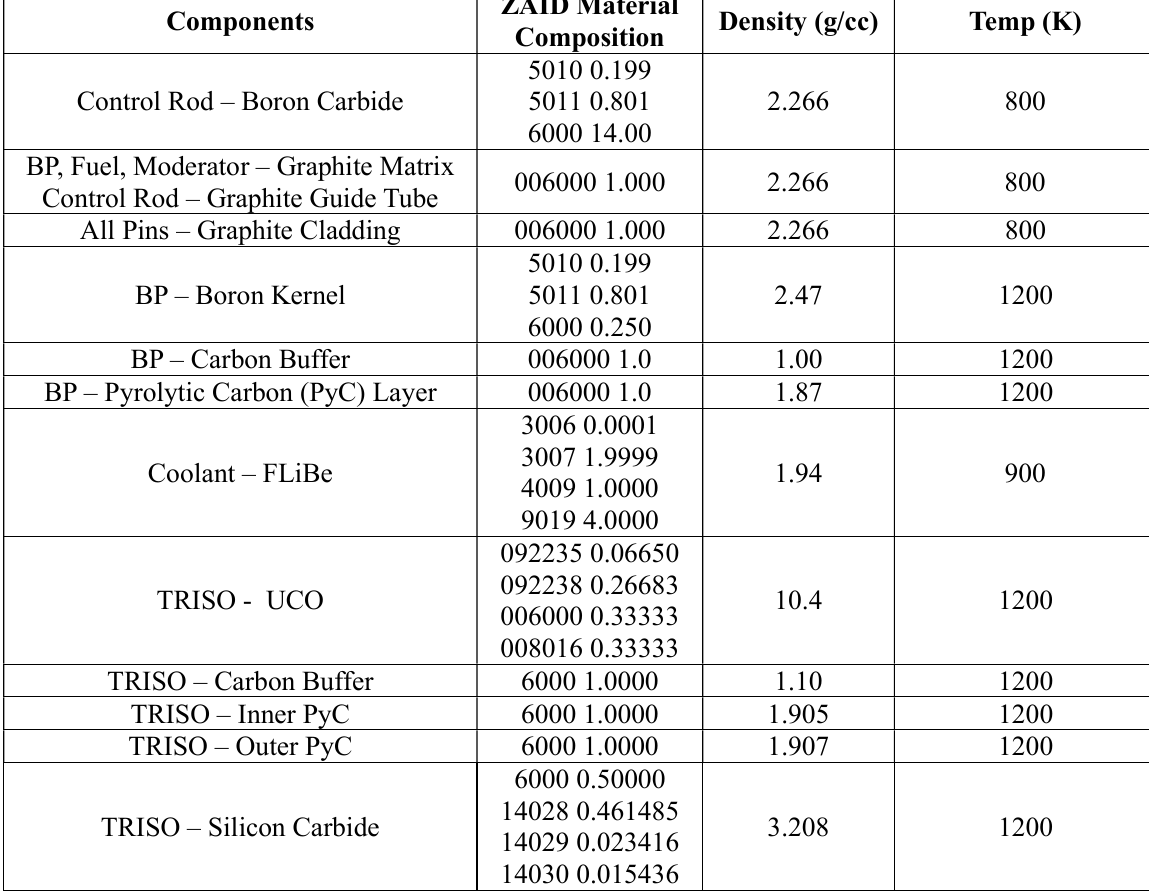
Table I. Material